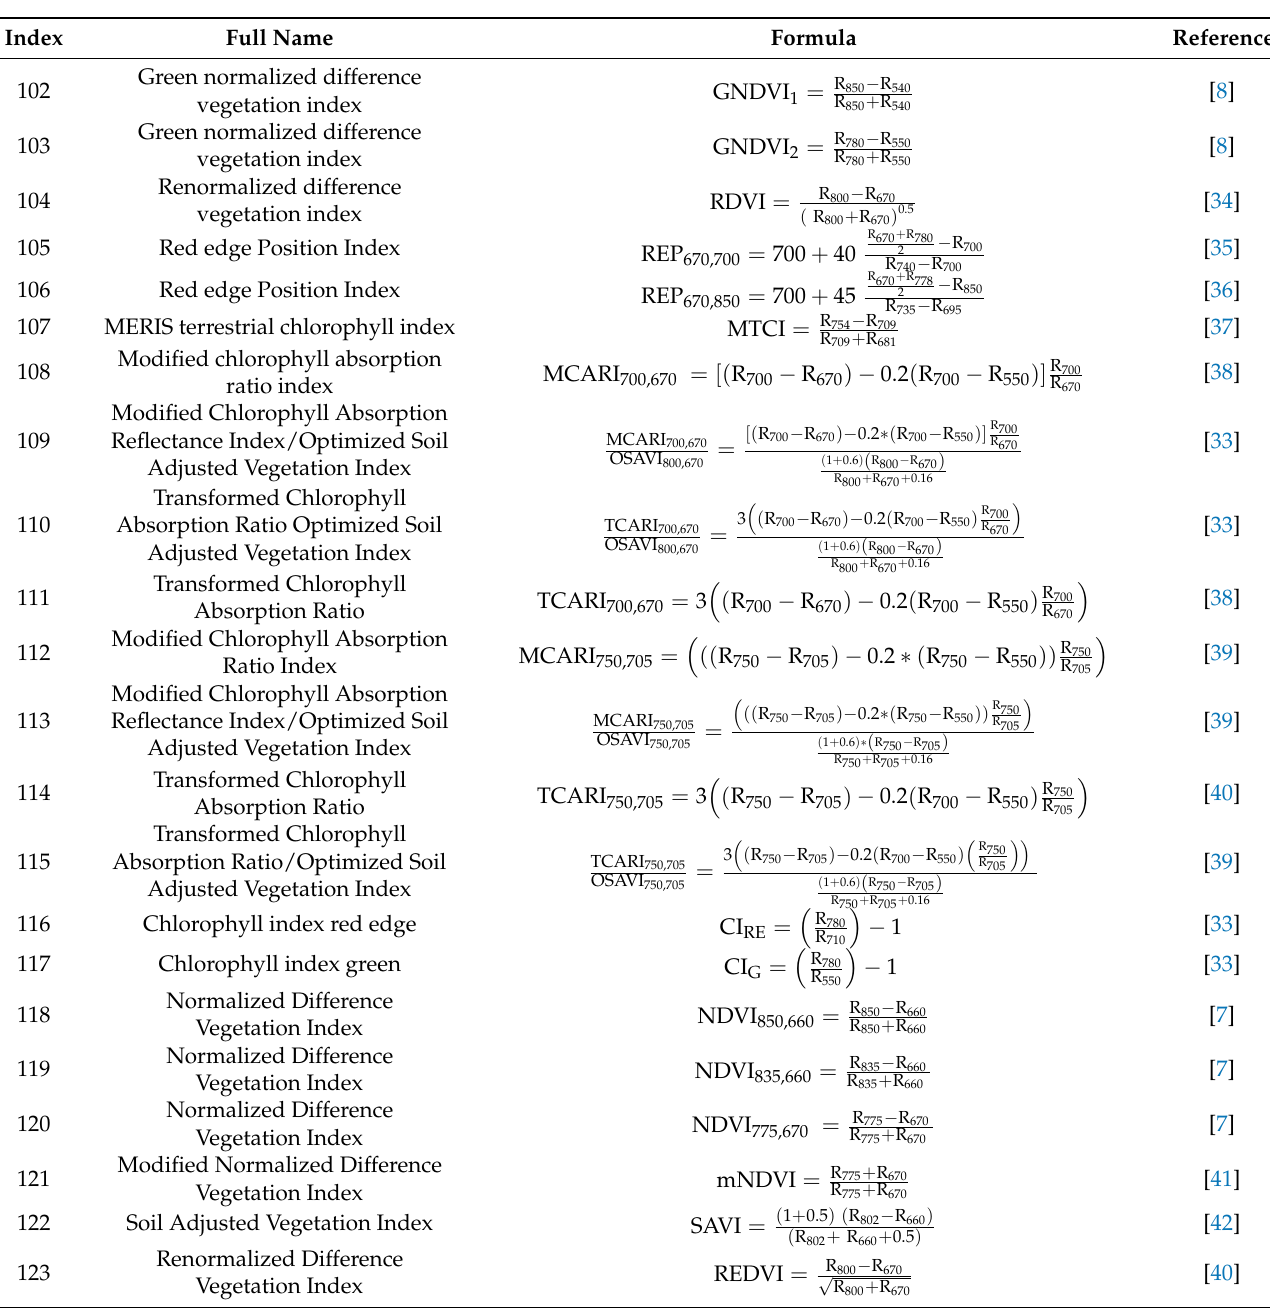
Table 1. Hyperspectral vegetation indices used in this work as regression variables. In the formulas, the variable R n refers to the central band wavelength expressed in nanometers. Indexing starts from 102 as band position indices from 1 to 101 are reserved to hyperspectral